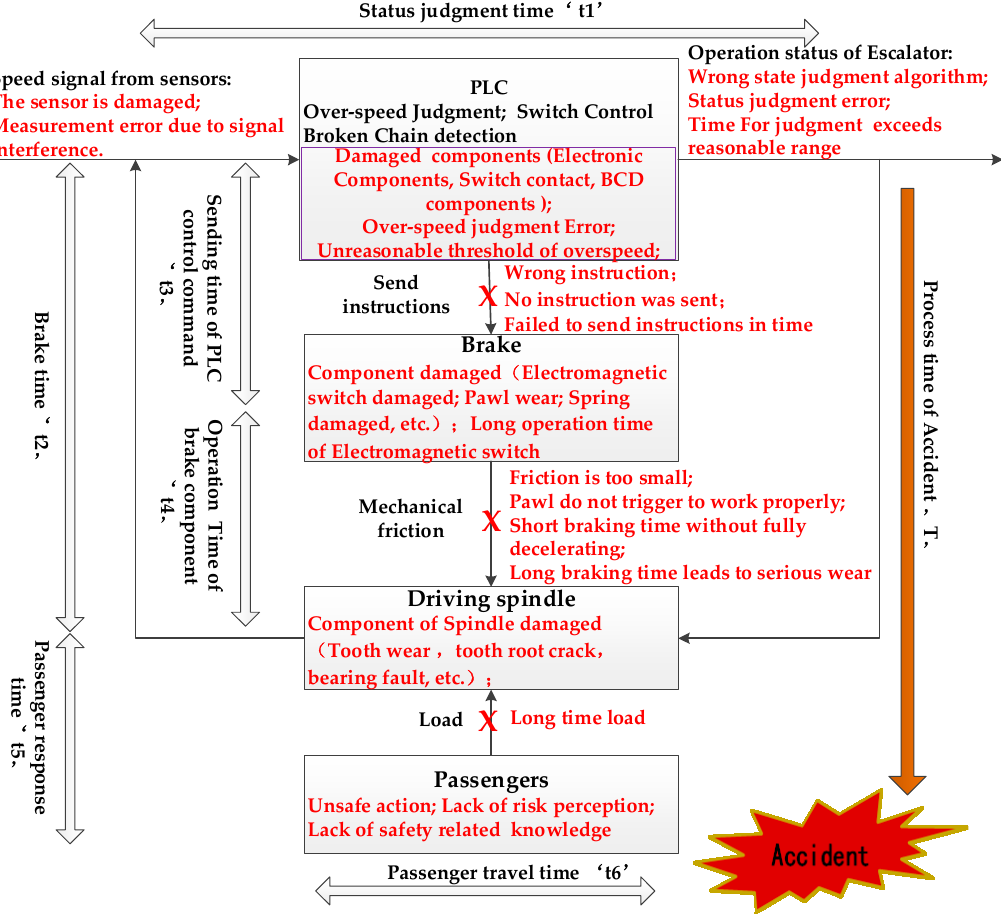
Figure 13. Hazardous unsafe control action of the braking process.